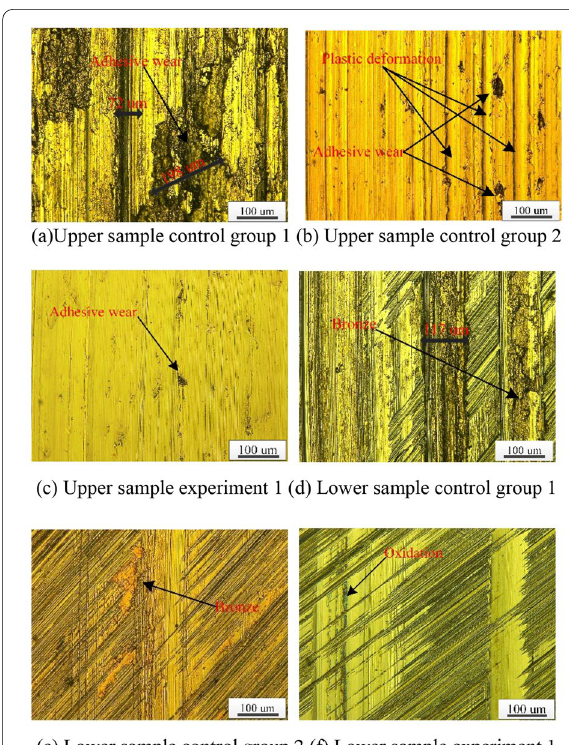
radius; and the curves labelled “contour 1”, “contour 2”,